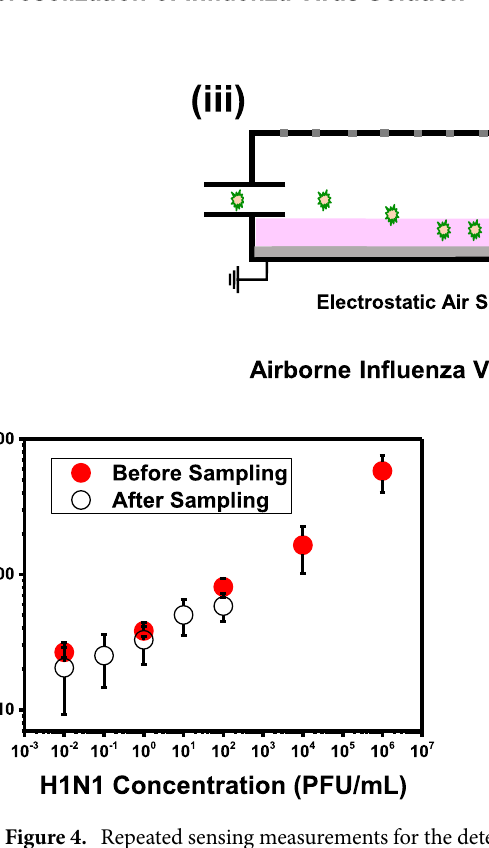
Figure 4. Repeated sensing measurements for the detection of airborne influenza A (H1N1) virus via the surface-amplified sandwich immunoassay. ( a ) Schematic diagram depicting the aerosolization and collection of influenza virus solution. ( i ) Aerosolization of influenza virus solution. ( ii ) Dilution of the aerosolized influenza virus with clean air. ( iii ) Collection of the aerosolized influenza virus. ( b ) Dose-dependence response curves of surface-amplified immunoassay to influenza viruses before and after the aerosolization and collection processes. Each data point and error bar represents the average value and standard deviation of the experiments (n = 3). ( c ) Comparison of the sensing measurement results obtained before and after the sampling